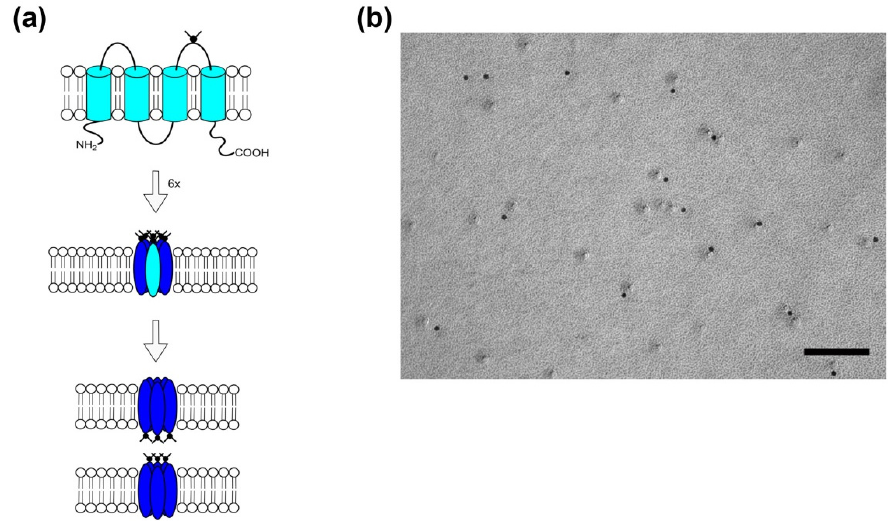
Figure 2. Assembly of Pannexin channels in the plasma membrane of eukaryotes. ( a ) Pannexins insert with four transmembrane domains (lighter blue; top panel) in the plasma membrane of cells. The second extraplasmic loop comprises an N-glycosylation site at residue N254 (black appendage). The pannexin hexamer forms the transmembrane channel (blue; middle panel). The glycosylation is thought to prevent the formation of intercellular pannexin gap junctions (lower panel). Schematic drawings are not to scale. ( b ) Pannexins do not assemble in gap junction-like structured plaques upon over-expression in HEK 293-cells [51]. Shown are freeze-fractured membranes of Panx1-EYFP-transfected cells after immunolabeling using anti-GFP antibodies, detected by 12 nm colloidal gold-coupled secondary antibodies (black dots). Scale bar 100 nm.